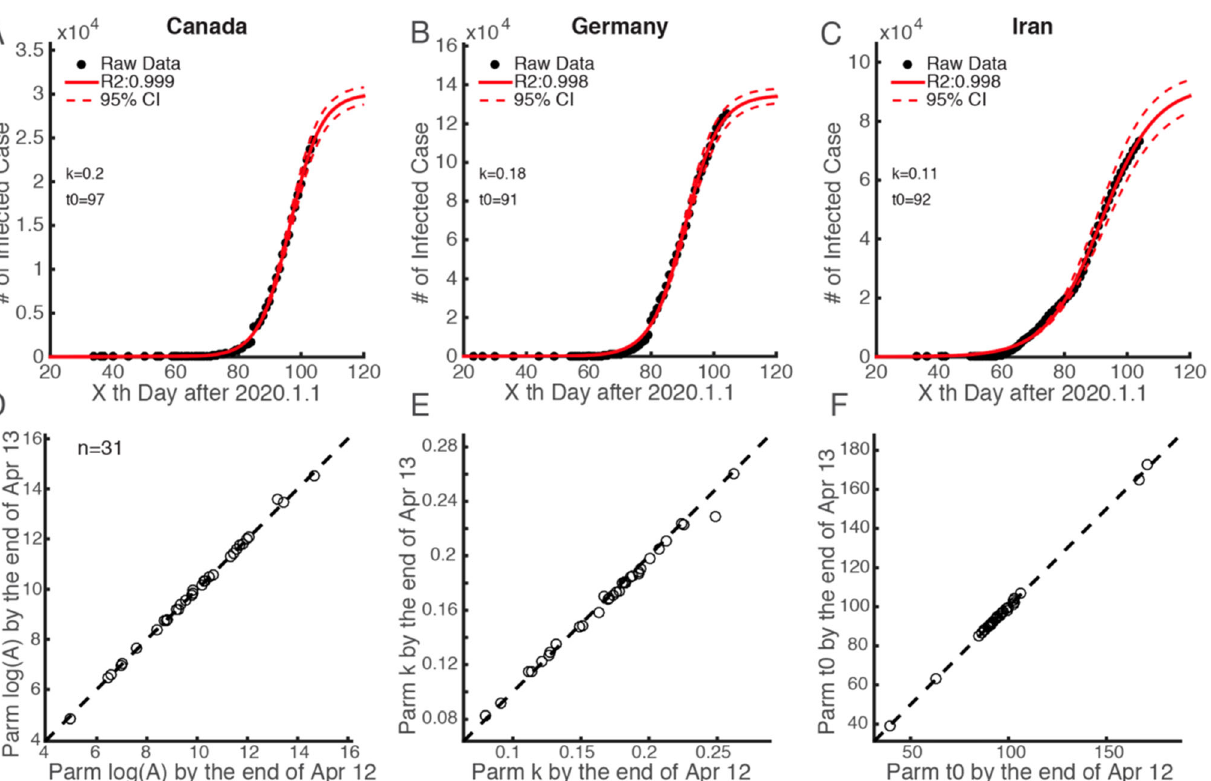
Fig. 5 Example countries for the time series of COVID-19 infected cases with corresponding fitted curves around the world and their temporal stability